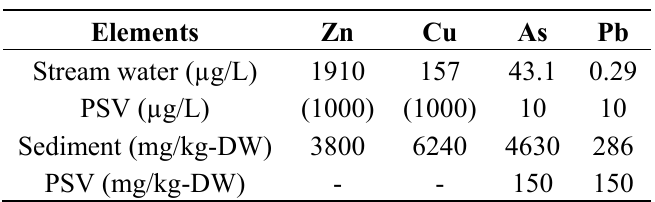
Table 8. Maximum potentially toxic elemental concentrations of stream water and sediments in a waste dump in Okayama, Japan and pollution standard values (PSV) stipulated by the ministry of health, labor, and welfare and the ministry of the environment in Japan. (1000) in PSV for Zn and Cu indicates a toxicity levels for aquatic habitats. DW: dry weight